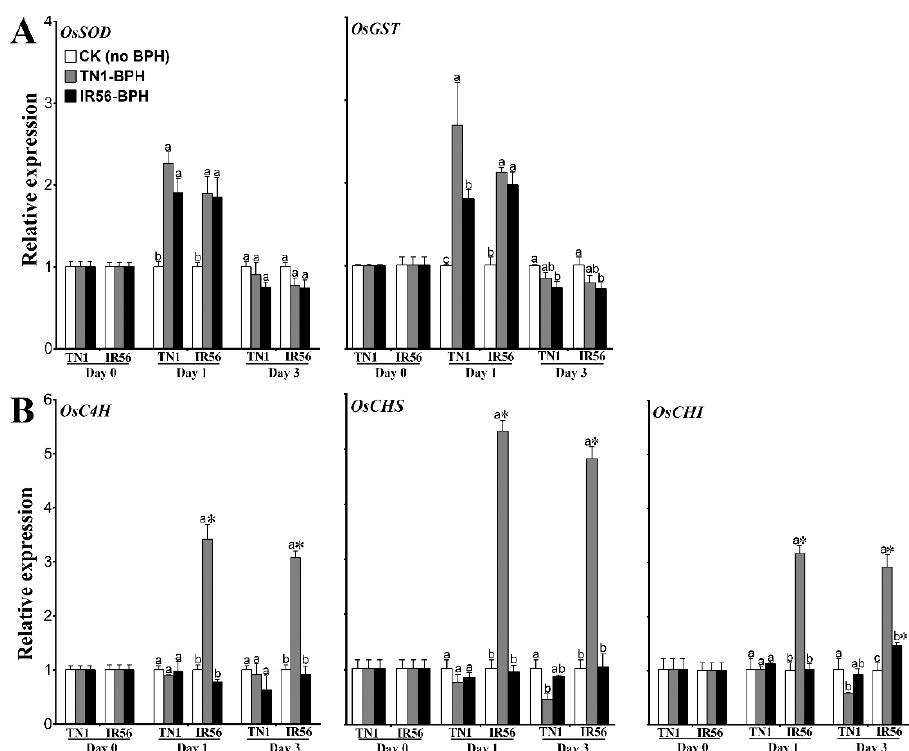
Figure 4. The expression profiles of phenylpropanoid biosynthesis genes and reactive oxygen species (ROS)-responsive genes in the IR56 and TN1 rice varieties under infestation by two different BPH populations. ( A ) ROS-responsive genes. ( B ) Phenylpropanoid biosynthesis genes. Data are denoted